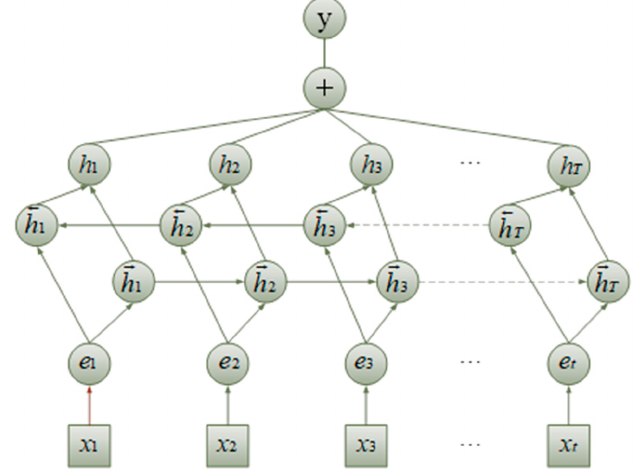
Figure 2. BILSTM model structure diagram.